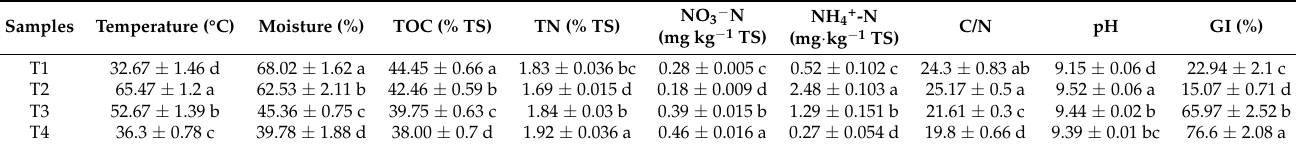
Table 1. Physicochemical properties of the compost in different